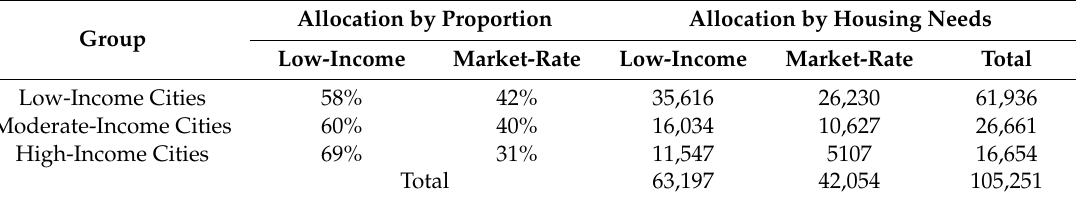
Table 4. The fair-share housing needs allocations for the sample by group (proportion and housing needs). The allocation covers the period of study (2007–2014). Sources: